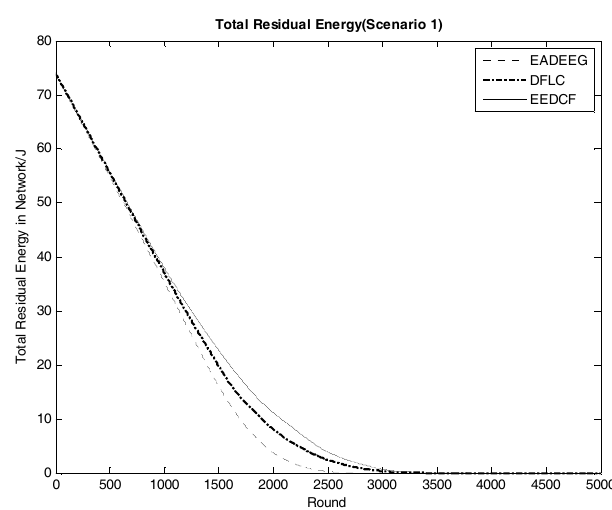
Figure 11. Comparison of system energy consumption of the three algorithms in Scenario 1 (The vertical axis denotes the energy of the system, and the horizontal axis denotes the round number). Table 6. System residual energy in Scenario 1.